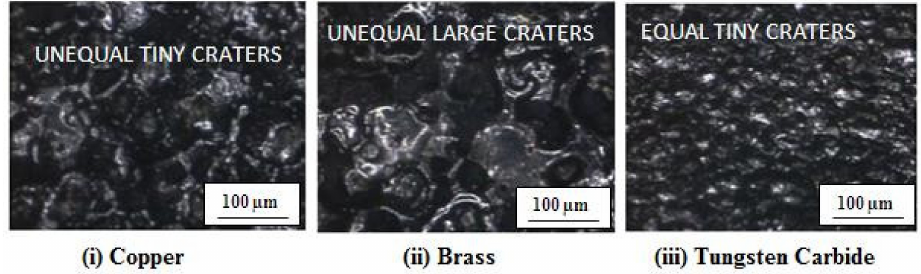
Figure 12. Surface morphology under machining conditions (V = 80 V, I = 15 A, and DF =